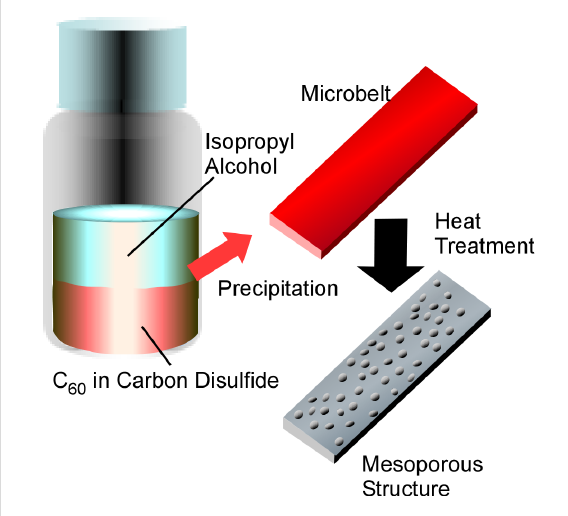
Figure 19: Synthesis of two-dimensional mesoporous C 60 -based car- bon microbelts by liquid–liquid interfacial precipitation using a carbon disulfide solution of C 60 and isopropyl alcohol followed by high-temper- ature heat treatment.